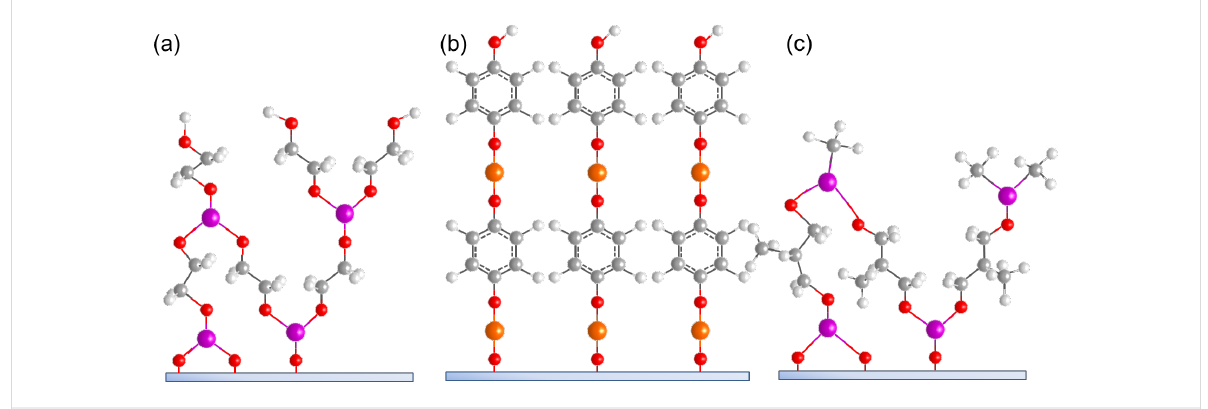
Figure 6: Schematic illustration of ALD/MLD inorganic–organic hybrid thin films deposited by using (a) TMA with ethane-1,2-diol, (b) DEZ with benzene-1,4-diol, and (c) TMA with oxiran-2-ylmethanol.